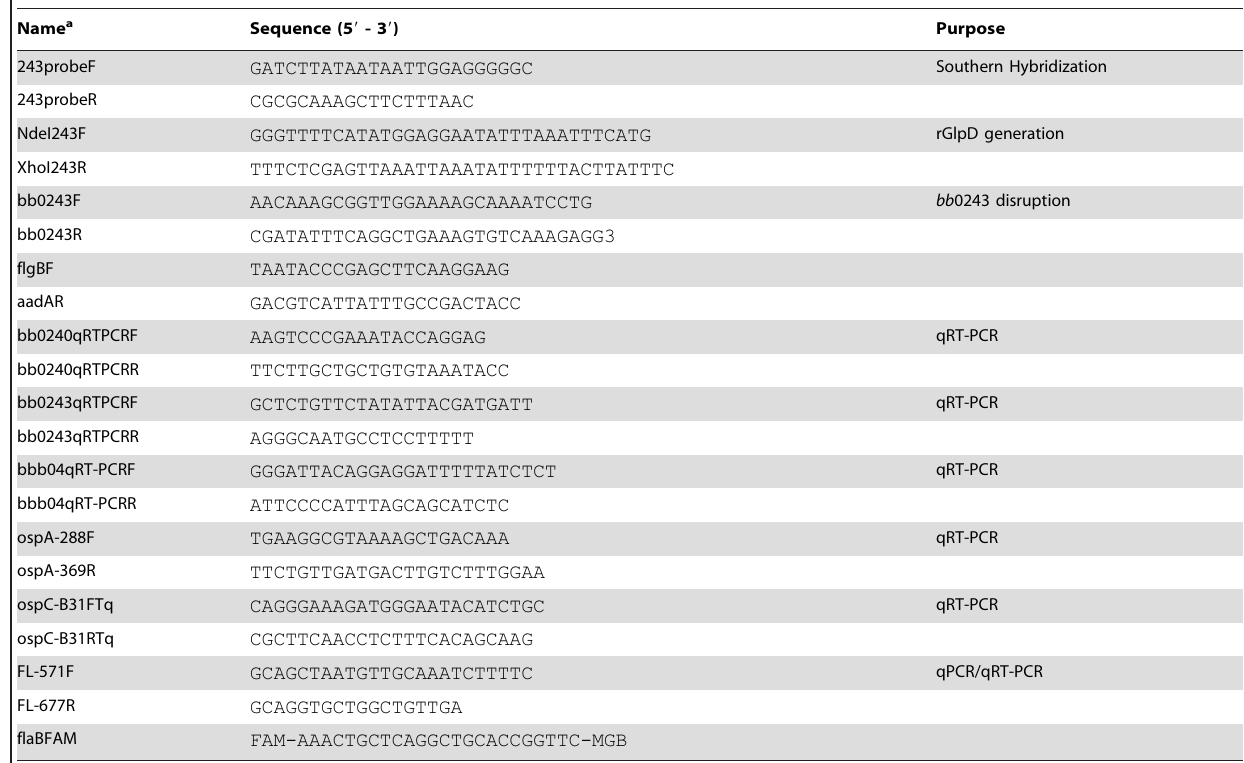
Table 4. Oligonucleotide primers used in this